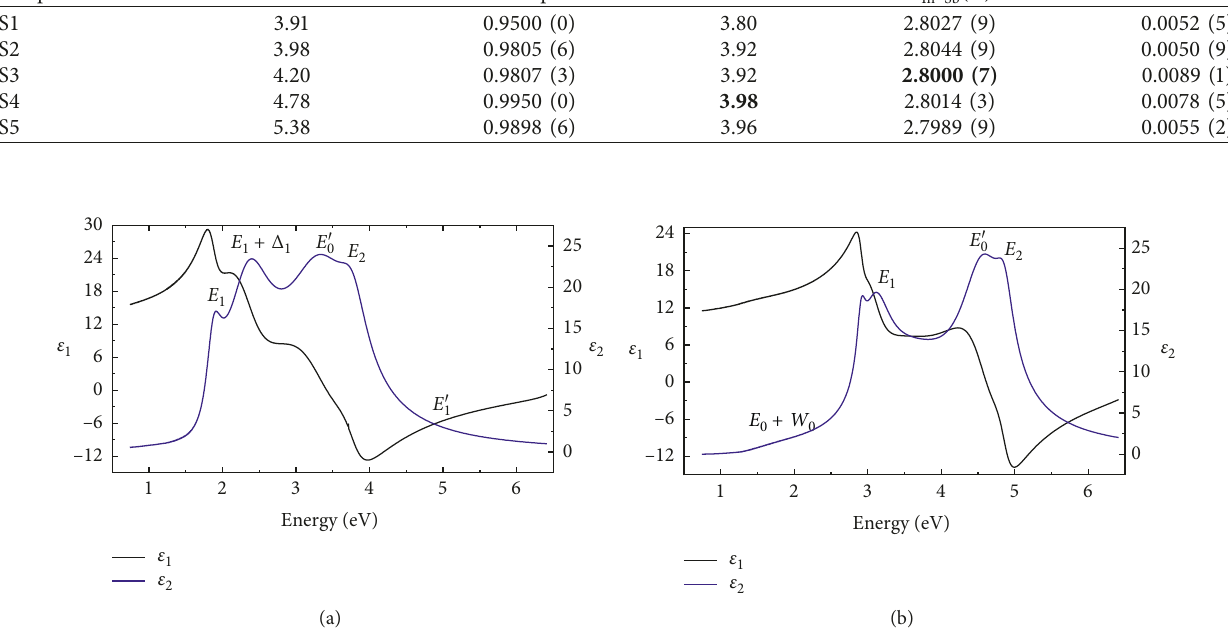
Table 3: The fitting results of the EXAFS data for first coordination shell atom around In atom. Sample